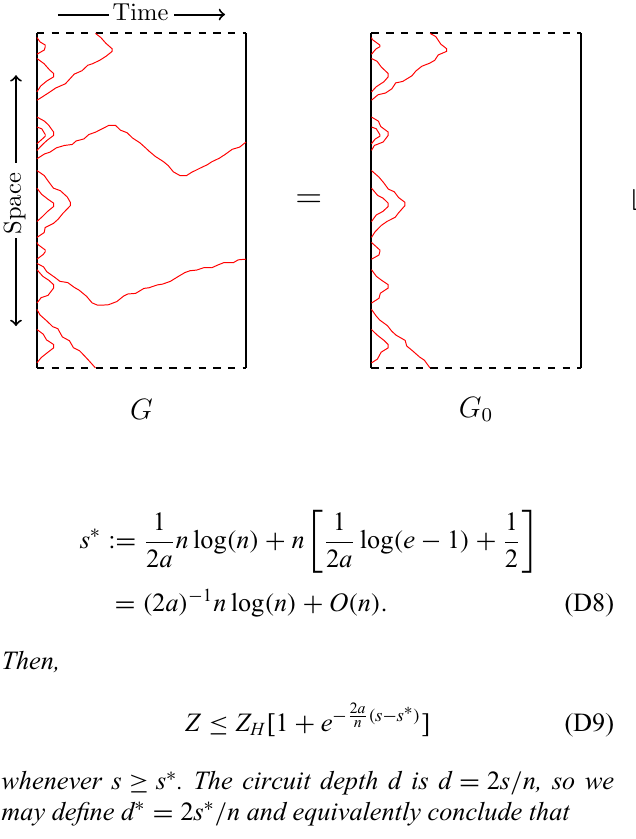
FIG. 5. A sketch illustrating unique decomposition of a domain-wall trajectory G into a disjoint union of one part, G 0 , where all domain walls annihilate prior to the end of the circuit, and another part, G U , where no domain walls